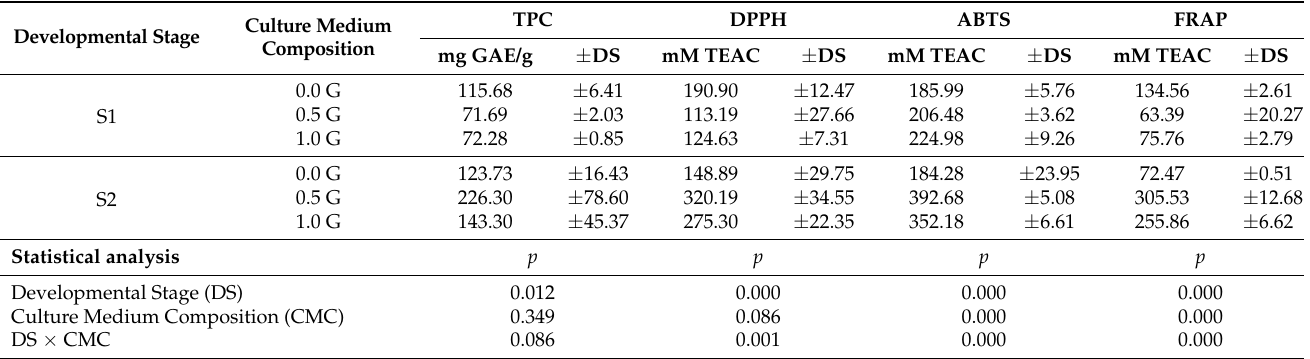
Table 3. Influence of developmental stage and culture medium composition on total phenolic contents (TPC), DPPH, ABTS and FRAP scavenging capacity of Moringa